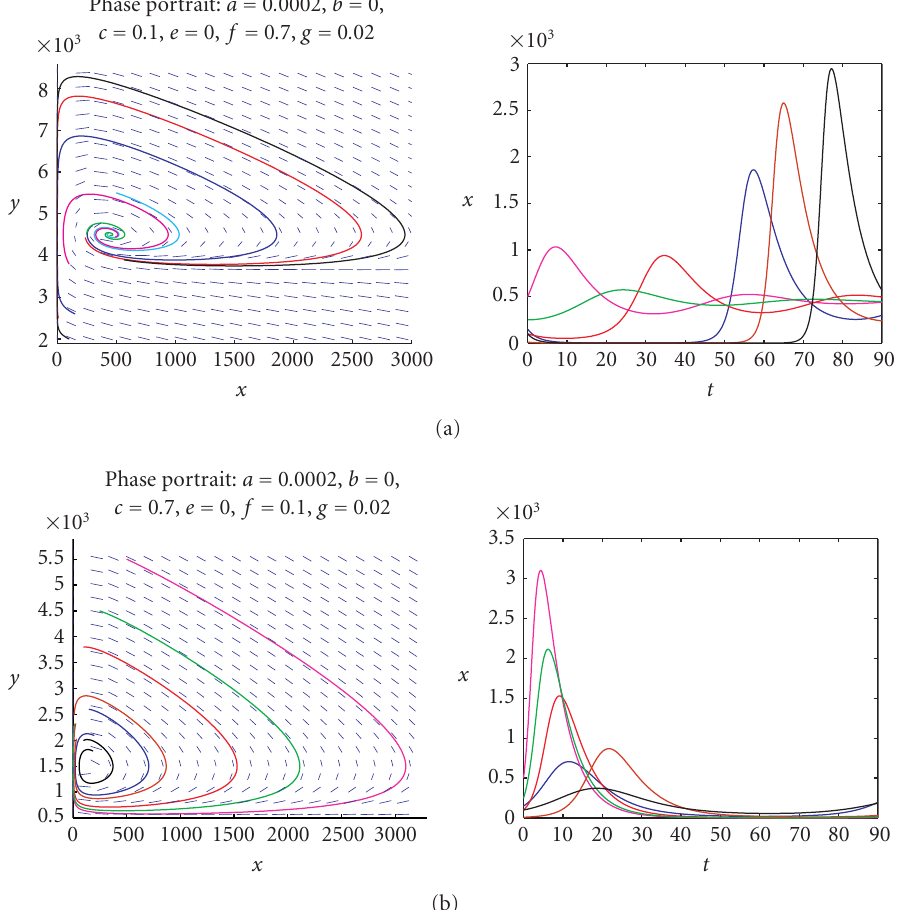
Figure 3.3. (a) Phase plot showing the flow field (with b = e = 0) and the asymptotic behavior of the dynamical system, when c < 1, f + c < 1, with f + c = 0 . 8 and c = 0 . 1. The fixed point is at x 0 = 450, y 0 = 4500. Trajectories starting from di ff erent initial conditions are shown in color. (b) Phase plot showing the flow field (with b = e = 0) and the asymptotic behavior of the dynamical system, when c < 1, f + c < 1, with f + c = 0 . 8 and c = 0 . 7. The fixed point is at x 0 = 150, y 0 = 1500. Trajectories starting from di ff erent initial conditions are shown in color. The same initial conditions as in Figure 3.3(a) are